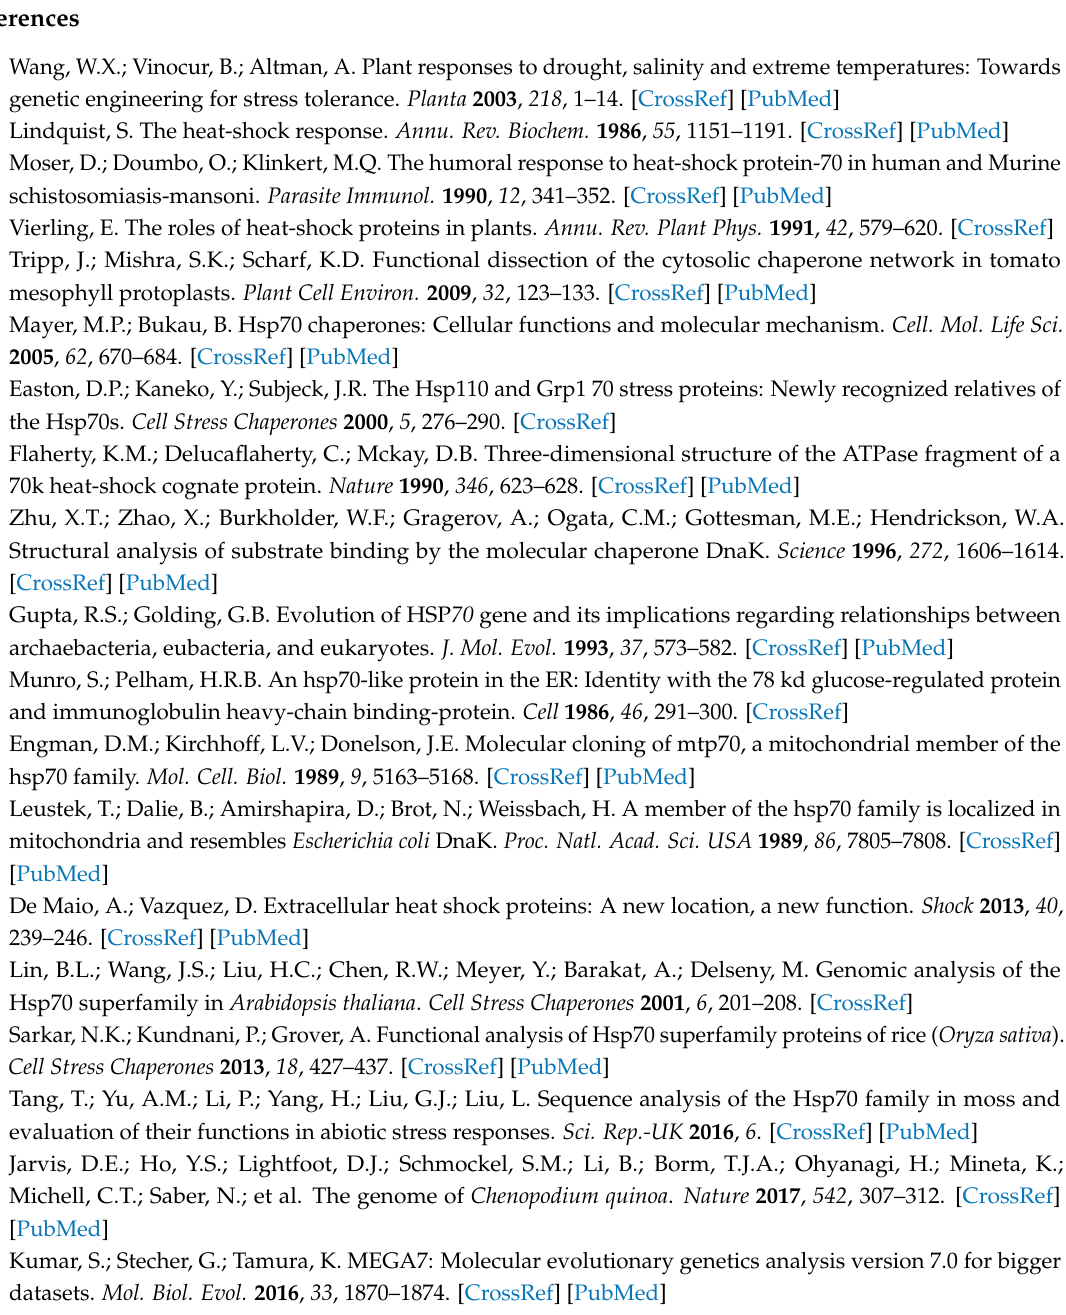
Figure 2. Figure S1: Electrophoresis result with extracted plant total